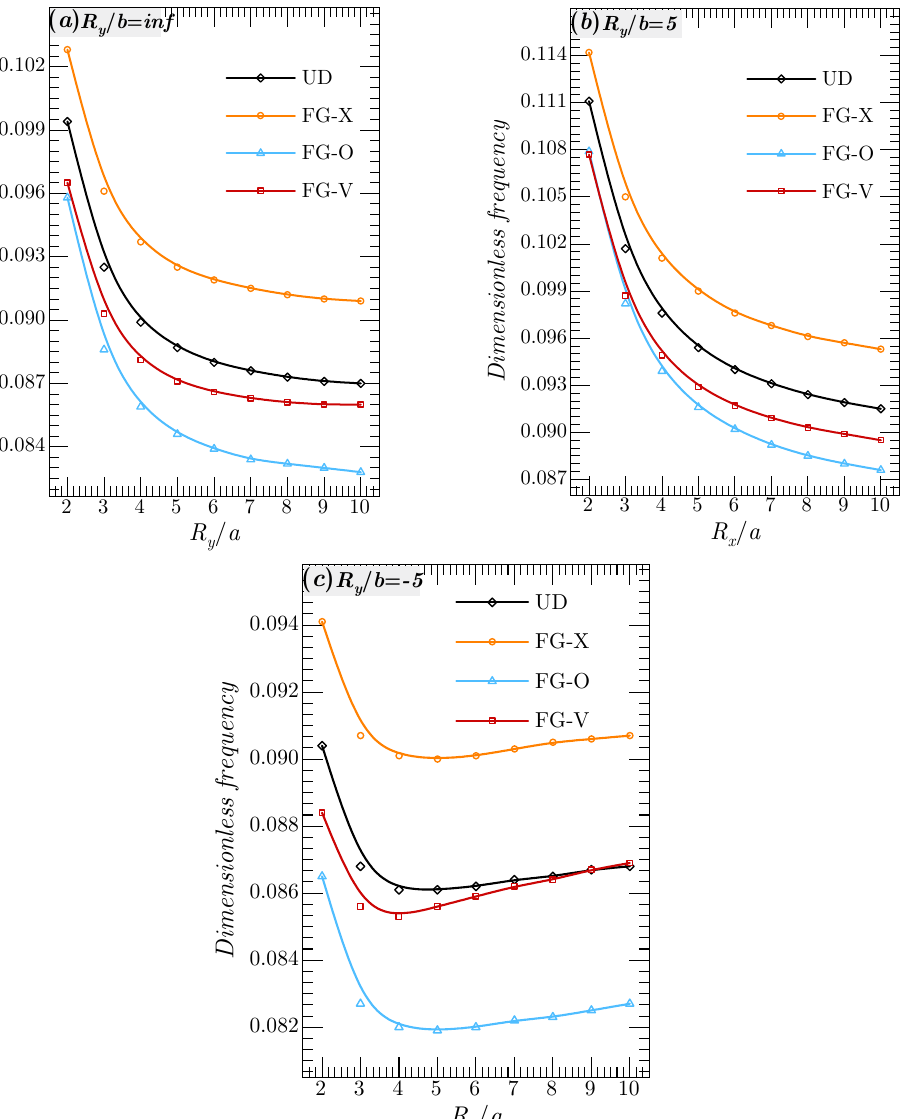
Figure 5. The effect of the radius of curvature R / a on the dimensionless frequency of various shell types (Cross-ply, SSSS, N = 9, b / a = 1, a / h = 10, V cnt = 0.01, V f max = 0.3, 𝑉 (cid:3040)(cid:3036)(cid:3041)(cid:3033) = 0.1 ).